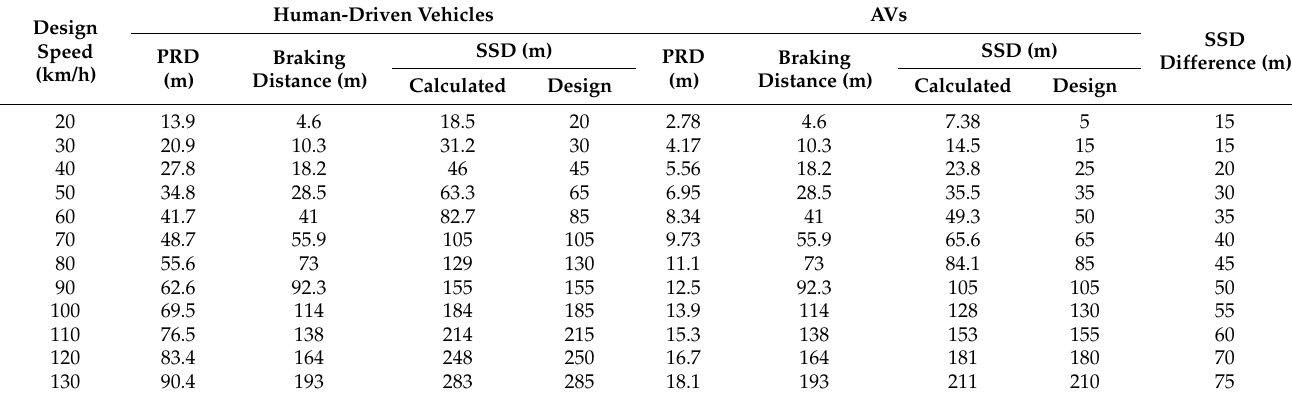
Figure 1. The stopping sight distance for human-driven vehicles and AVs. Table 1. SSD on level roads for human-driven vehicles and autonomous vehicles